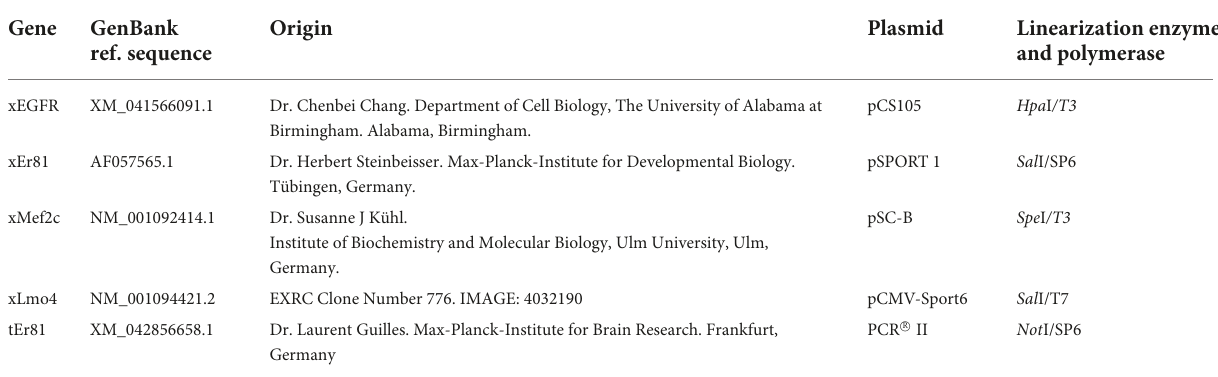
TABLE 2 List of gene markers used, sequence of the gene in the construct, origin of the plasmid and enzymes employed to synthesize the antisense riboprobe. Gene GenBank ref.